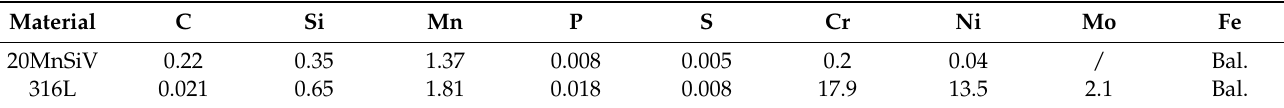
Table 2. Chemical compositions of 20MnSiV and 316L stainless steel (mass %).